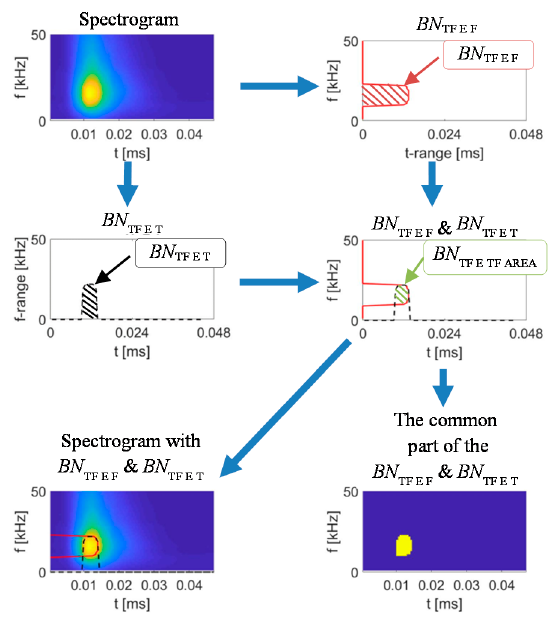
Figure 9. Visualization of the envelopes extraction procedure.